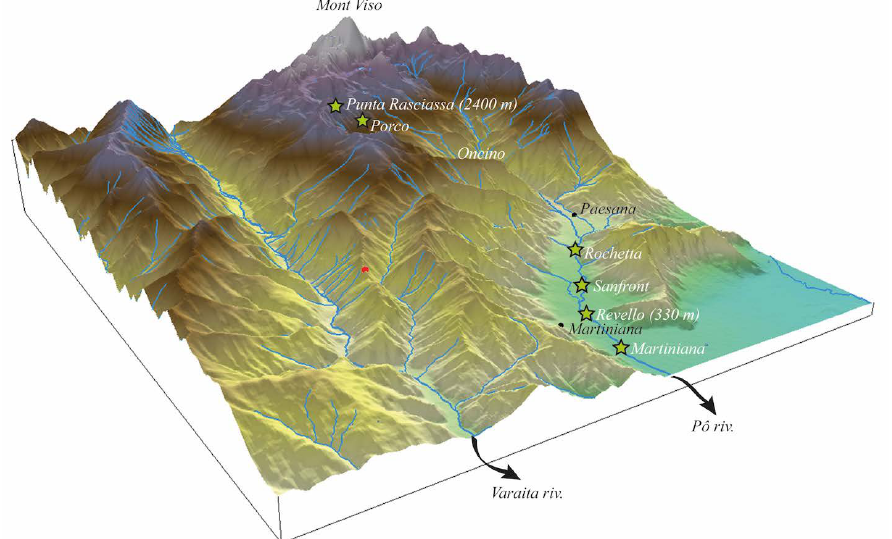
Figure 7 . Location of the geological samples. Mapping F. Prodéo, ESRI Data and Maps (licence MSHE C.N. Ledoux et